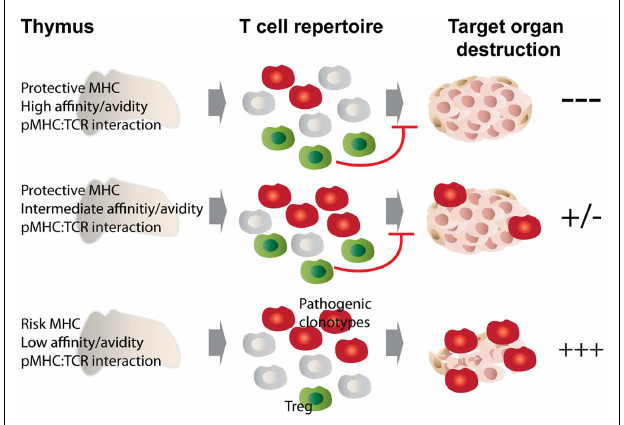
FIGURE 1 | MHC class II polymorphisms afford autoimmune disease resistance through shaping the T cell andTreg repertoire . MHC class II molecules that afford disease risk allow the escape of pathogenic autoreactive T cells from central tolerance, while protective MHC class II molecules confer disease resistance through promoting negative selection as well as autoreactiveTreg development.We propose that these processes are governed by the affinity/avidity with which pMHCs are bound byTCRs. Disease-protective pMHC interact with MHC-promiscuous, autoreactive thymocytes with increased affinity/avidity (top and middle panels), leading to enhanced negative selection and agonist selection of Tregs, which then dampen the autoimmune response through various mechanisms. In the bottom scenario, low affinity/avidity interaction between pMHC and autoreactiveTCRs leads to defective negative selection andTreg development, with the net result of autoimmunity.